Question: Compose a caption that would accompany this figure in a paper.
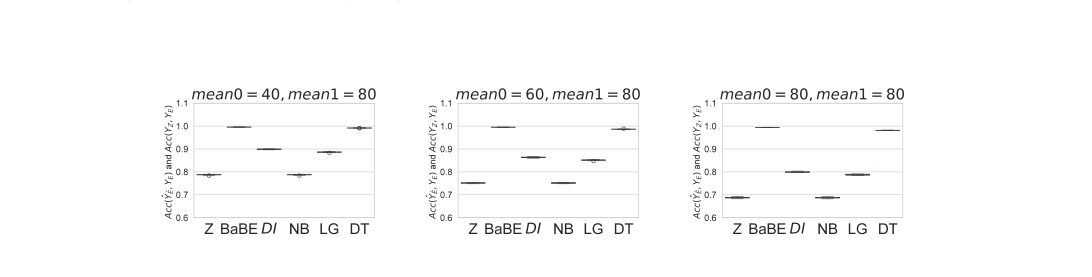
Answer: Experiments on the synthetic data sets: The accuracy between ˆ𝑌𝑍and 𝑌𝐸, and between ˆ𝑌ˆ𝐸and 𝑌𝐸.